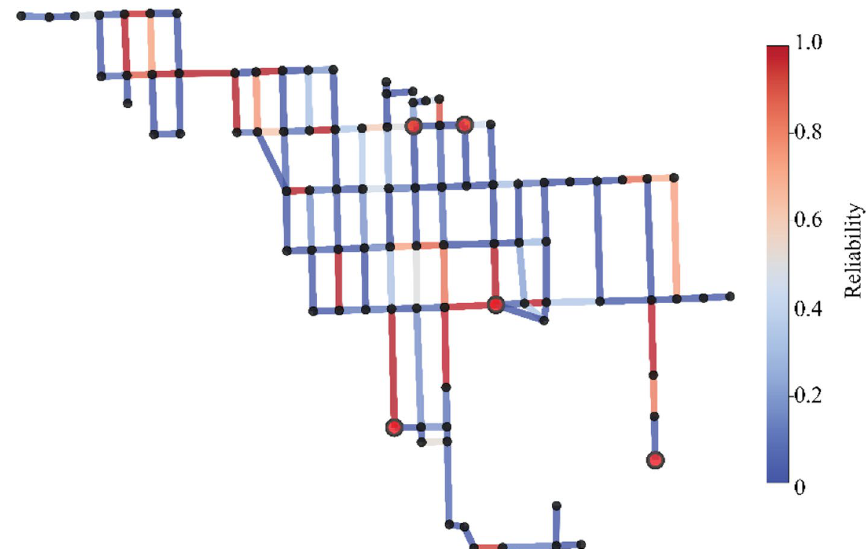
Fig. 6 Post-earthquake road segment reliability map (locations of emergency response facilities are shown as red point.